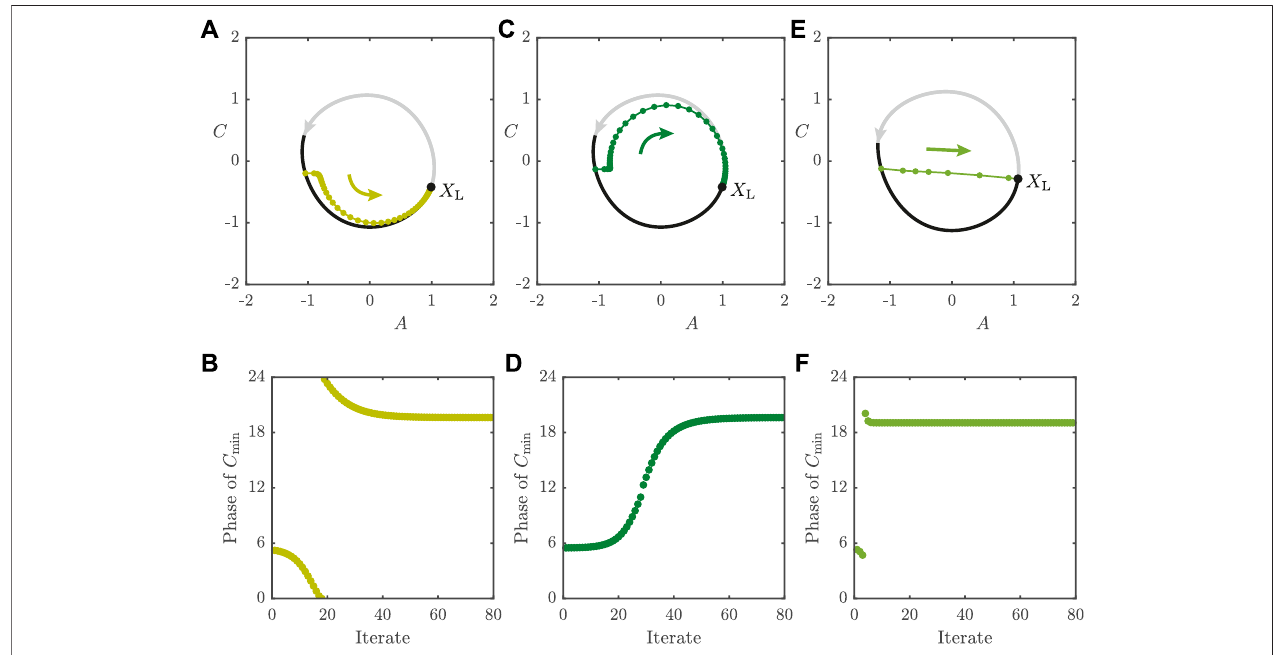
FIGURE8| Longre-entrainmenttimesfor I (cid:1) 50throughphase-advancement[panels (A) + (B) ]orphase-delay[panels (C) + (D) ]. (E) + (F) :Fastre-entrainmentfor I (cid:1) 1000, whereby a trajectory takes a “ shortcut ” instead of advancing or delaying. Note the panel labelling is now column-wise. Panels (A, C, E) show the stable limit cycle for the relevant value of I , the grey arrow indicates the direction of the phase shift of the light/dark cycle. The point of zero phase X L along the orbits is marked by a black circle. The coloured arrows indicated the direction the iterates move around the orbit. Panels (B, D, F) show the evolution of the phase of the C min values relative to the forcing